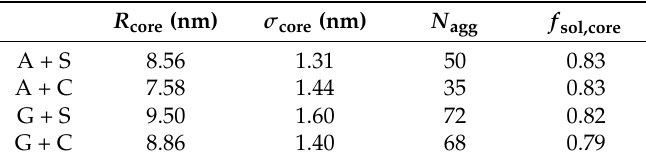
Figure 5. SANS profiles of 0.5 wt % C3Ms for ( a ) A + S; ( b ) A + C; ( c ) G + S and ( d ) G + C using dOA block copolymers under the core contrast system. The symbols are the SANS data, and the solid lines are the model fits. Table 2. SANS fitting result of core contrast